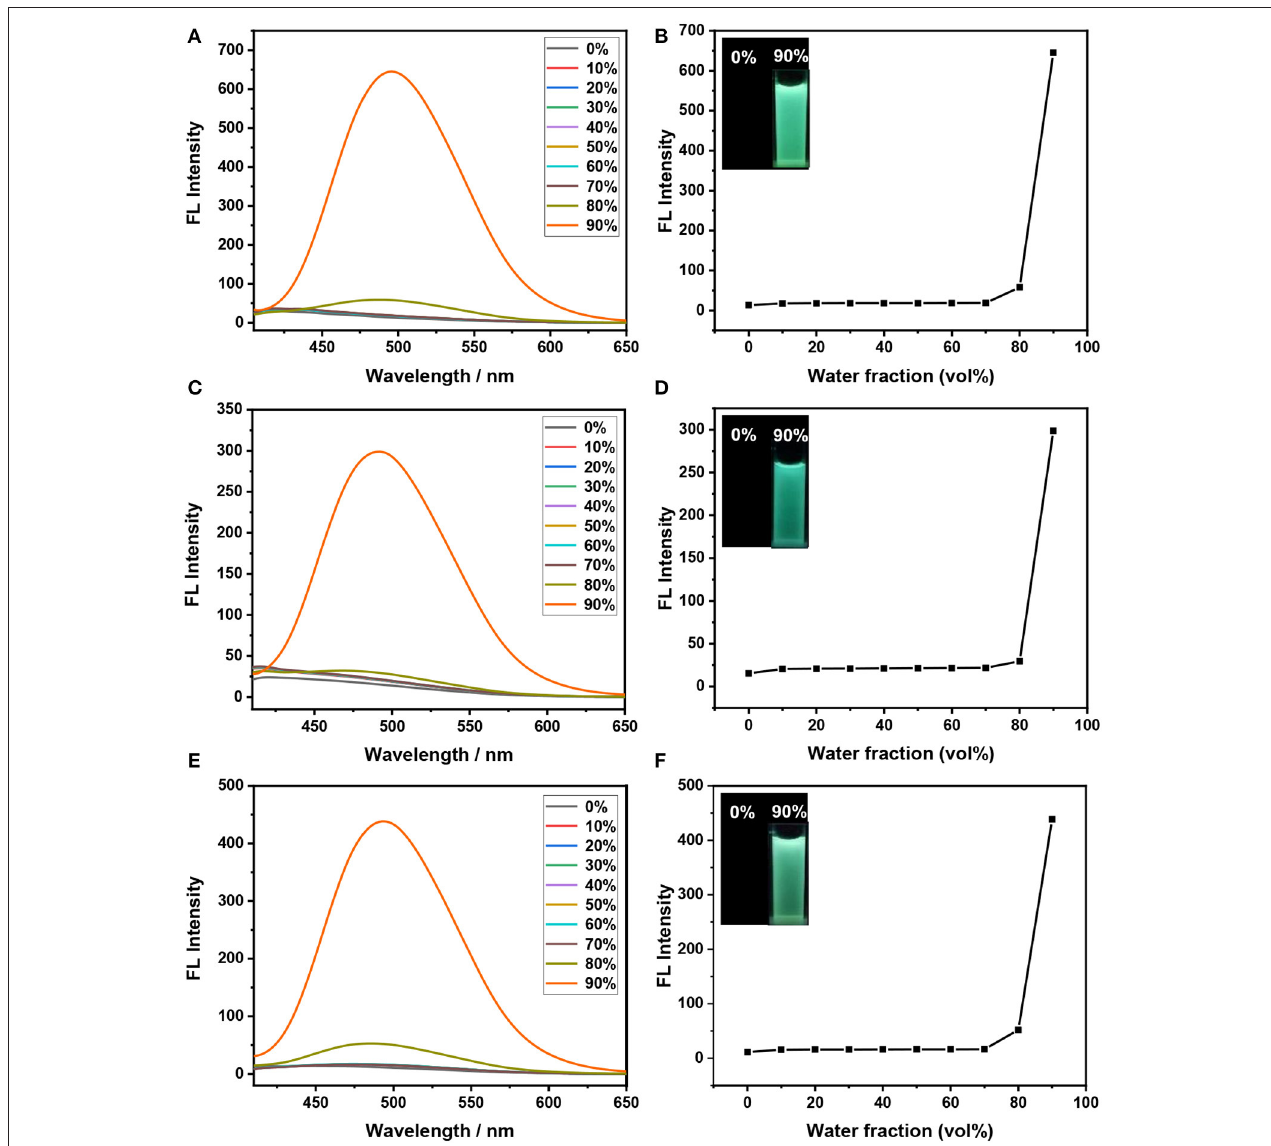
FIGURE 2 | Fluorescence spectra of dithienylethenes 1–3 in different H 2 O/THF (v/v)-mixed solutions (2 × 10 − 5 mol/L) (A,C,E) ; the dependence of the fluorescence emission intensity on the water fraction ( f w ) (Insert: photographs of dithienylethenes 1–3 in 0% and 90% water solutions under 365nm UV light (B,D,F) , (A,B) for dithienylethene 1 ; (C,D) for dithienylethene 2 ; (E,F) for dithienylethene 3